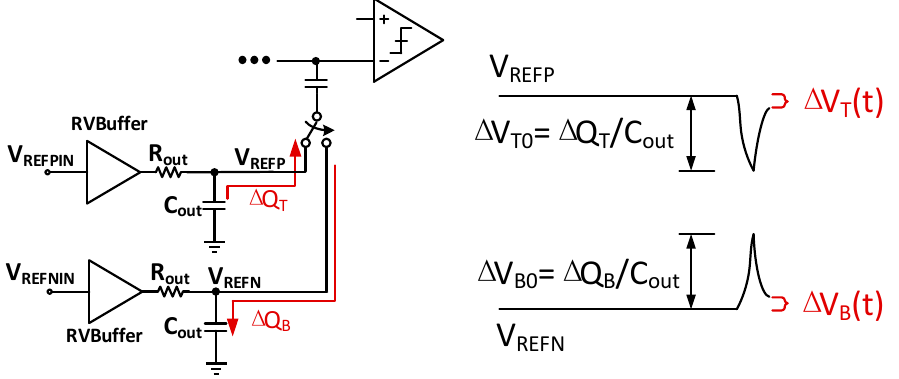
Figure 8. Sinking and overshoot of reference voltage during sampling.